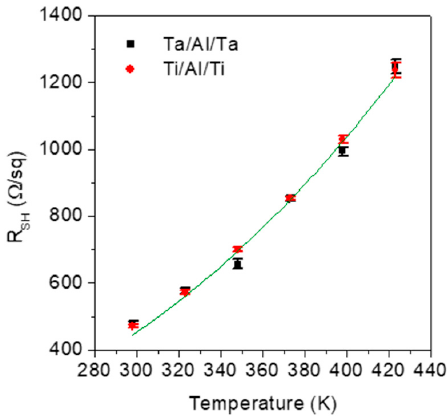
Figure 6. Sheet resistance R SH versus temperature T for the AlGaN / GaN heterostructures with Ta / Al / Ta (squares) and Ti / Al / Ti (circles) contacts. The continuous lines represent the fits of the experimental data obtained assuming R SH ∝ T β , with β = 2.87. Figure 7 reports the values of ρ c versus the measurement temperature T for the two contacts.